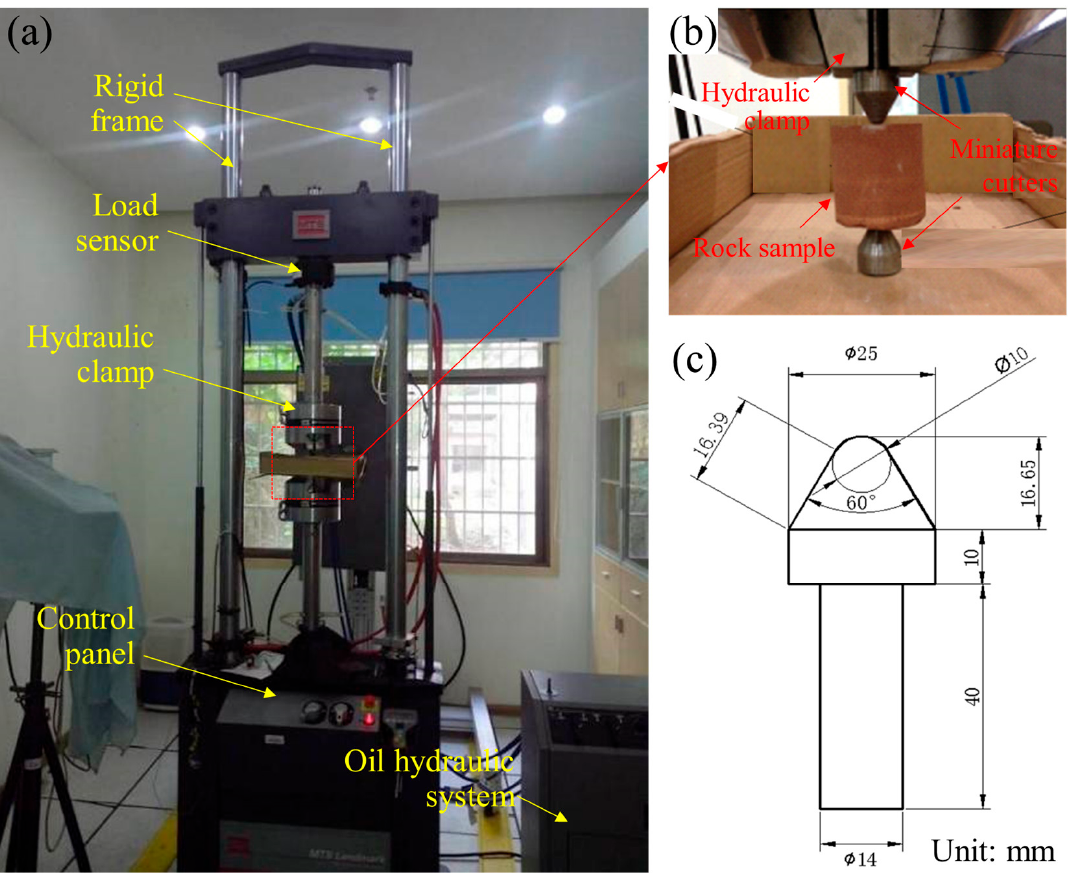
Figure 2. The vibration point-load apparatus: ( a ) photographic view; ( b ) detailed view of the rock sample and the miniature cu tt ers; ( c ) geometry of the cone-shaped cu tt er.